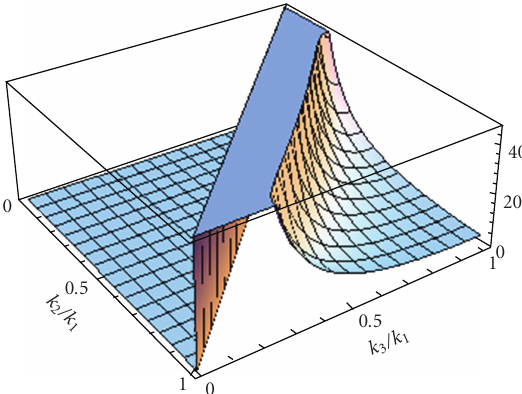
Figure 10: Shape of (cid:20) S λ